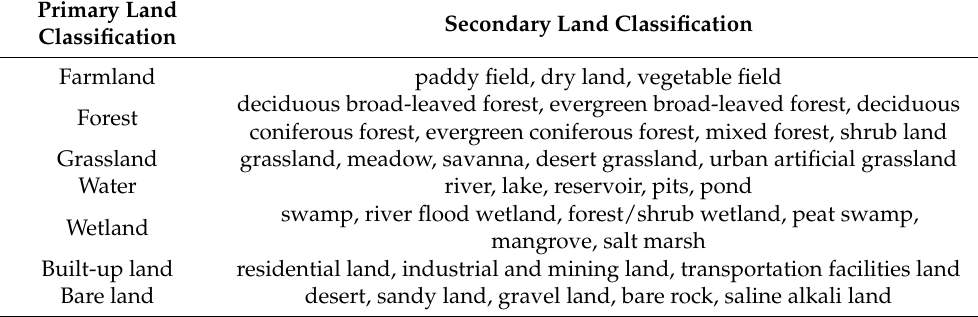
Table 2. Criteria for secondary land